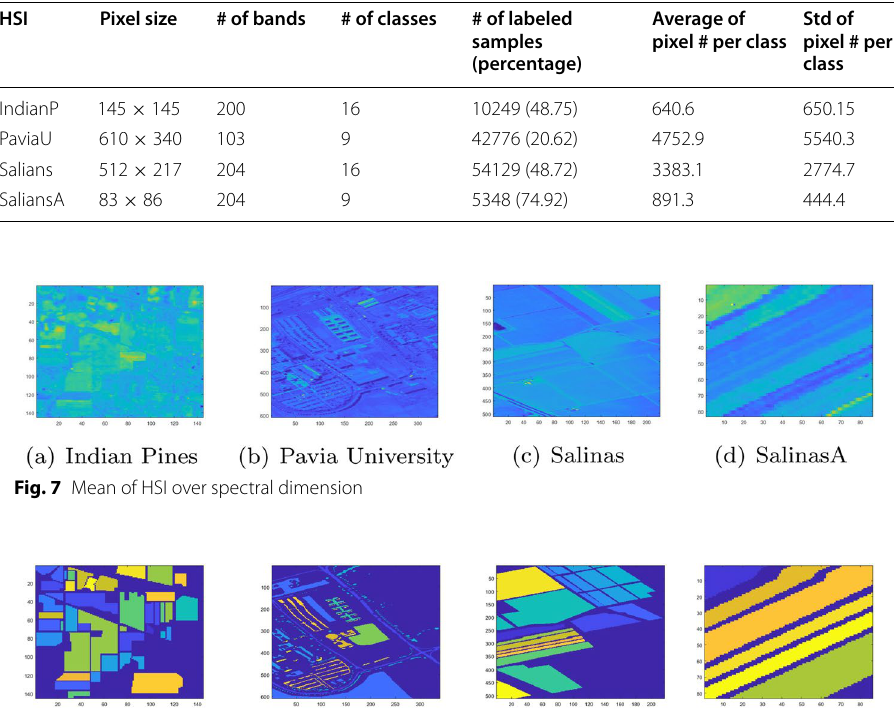
Table 1 Statistics of different HSI datasets